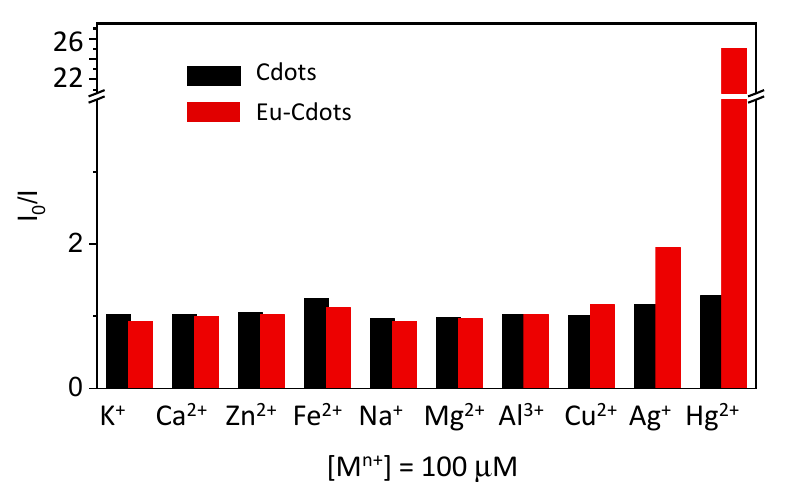
Figure 4. Ratio of the emission intensities before ( I 0 ) and after ( I ) addition of 100 µ M of several metal cations upon excitation at 396 nm of a Cdots ( black ) and Eu-Cdots ( dark red ). A break was introduced in the y -axis to better convey the details of the response. A quenching of emission by a factor of 2 is observed for Ag + , while Hg 2+ shows a quenching by a factor of 25. The enhanced sensitivity to the presence of metal cations of Eu-Cdots, with respect to undoped Cdots, reflects the differences in structure and availability of active sites for cation binding of the two nanomaterials. The TEM images show that the average size of the Eu-Cdots is larger than that of undoped Cdots suggesting that there is an incorporation of Eu 3+ ions in the graphene sheets during the growth of the sp 2 network. It is possible that the Eu 3+ becomes part of the carbon layer due to coordination with the carboxylic groups of the citric acid and the carbonyl groups of urea during the condensation reactions to form the sp 2 clusters [49]. Eu 3+ acts as a nucleating center expanding the overall size of the Cdots. In this case it is not unreasonable to expect a smaller size for the sp 2 clusters in each layer due the presence of oxygenated defects induced by incorporation of Eu 3+ in the carbon network, as it was effectively estimated based on the Raman spectroscopy data. Furthermore, the incorporation of Eu 3+ in the Cdots might also affect the structure of the Cdots by inducing interaction between stacks of layers with different